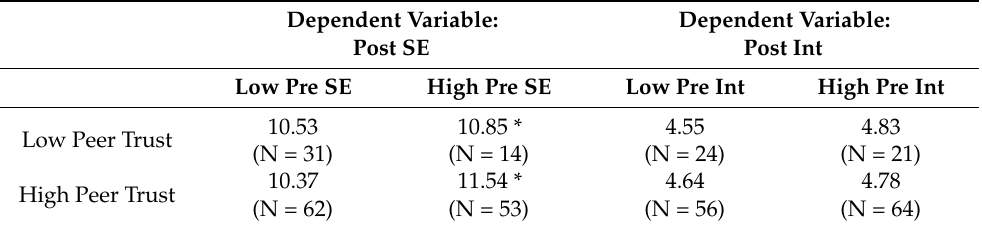
Table 2. Means Among Median Split